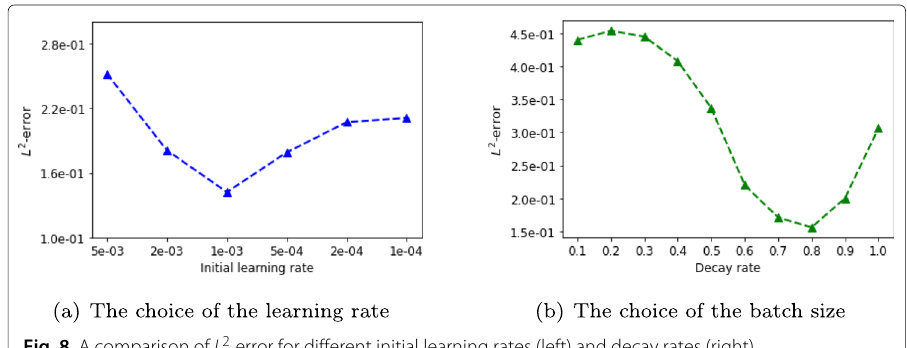
Fig. 8 A comparison of L 2 error for different initial learning rates (left) and decay rates